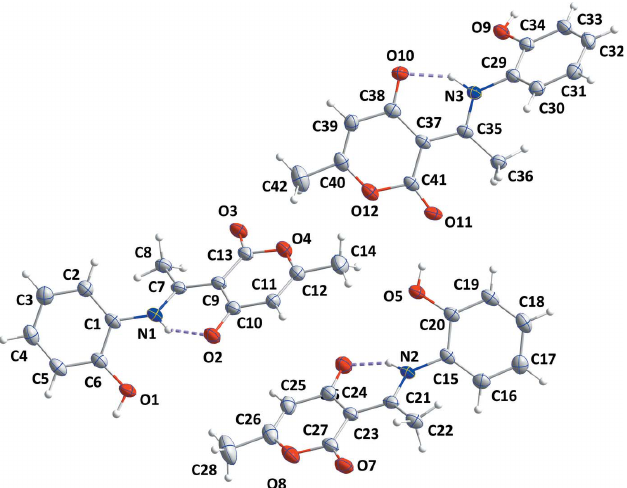
Figure 1 The asymmetric unit with the atom-labeling scheme and 50% probability ellipsoids. The intramolecular hydrogen bonds are depicted by dashed lines.